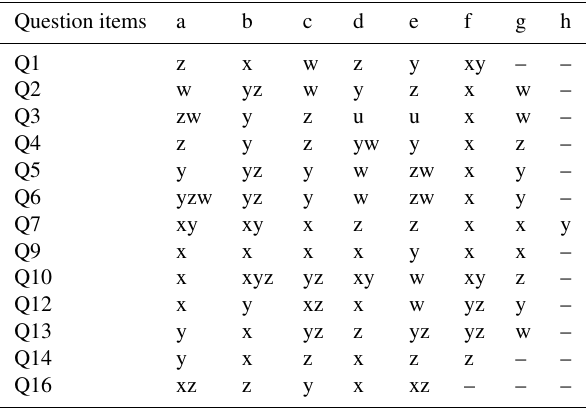
Table 3. Post hoc analysis results of pairwise Mann–Whitney U tests for the question items with Likert scale responses: a–h cor- respond to the question items shown in Table A1; u–z values sharing a letter are not significantly